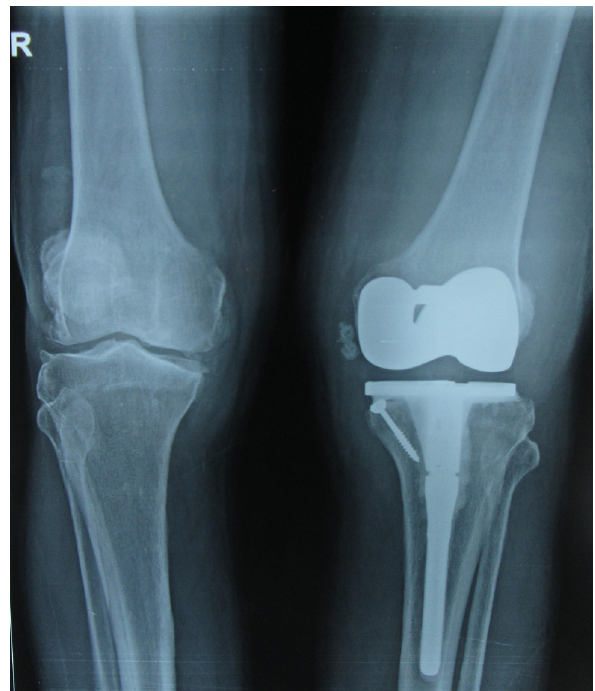
Figure 5. A standing anteroposterior radiograph of the left knee shows a well-fixed, well-aligned, total knee prosthesis with cemented tibial stem and a malleolar screw in the medial aspect.